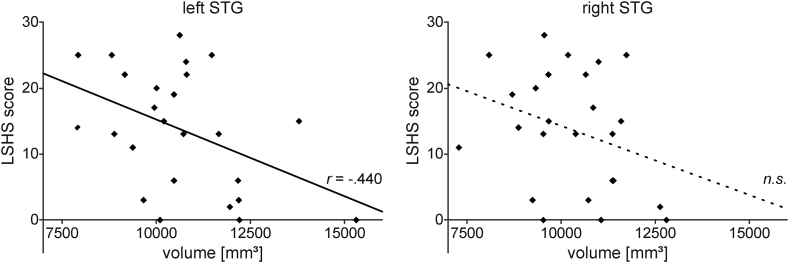
Relationship between STG volume and hallucination proneness. The scatter plots show scores of hallucination proneness (LSHS) as a function of the left and right superior temporal gyrus (STG) volume, respectively. The volume of the left STG (but not the right STG) showed a significant correlation with LSHS scores. Relationships that were significant (p < .05) in the multiple regression (see text) are indicated by sold lines and the partial correlation coefficient (r), non-significant (n.s.) by dashed regression lines. n = 25.